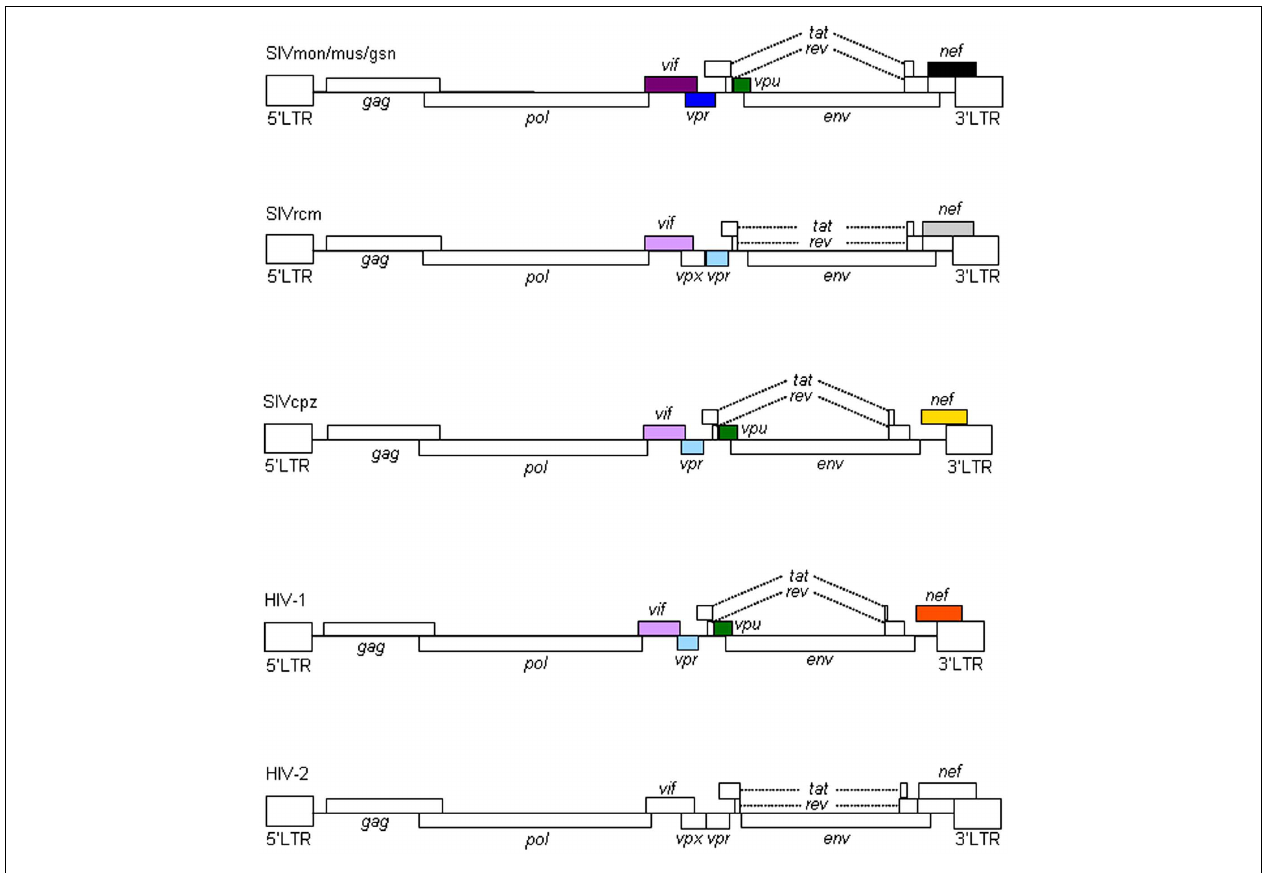
FIGURE 1 | Genome organization of primate immunodeficiency viruses. Various proviral genomes are schematically shown. As indicated by colored boxes, the vpr and vpu genes of SIVcpz/HIV-1 came from those of SIVrcm and SIVmon/mus/gsn, respectively. Also, the vif genes of SIVcpz/HIV-1